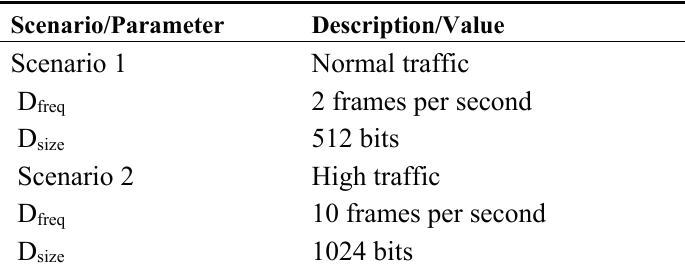
Table 2. Traffic parameter